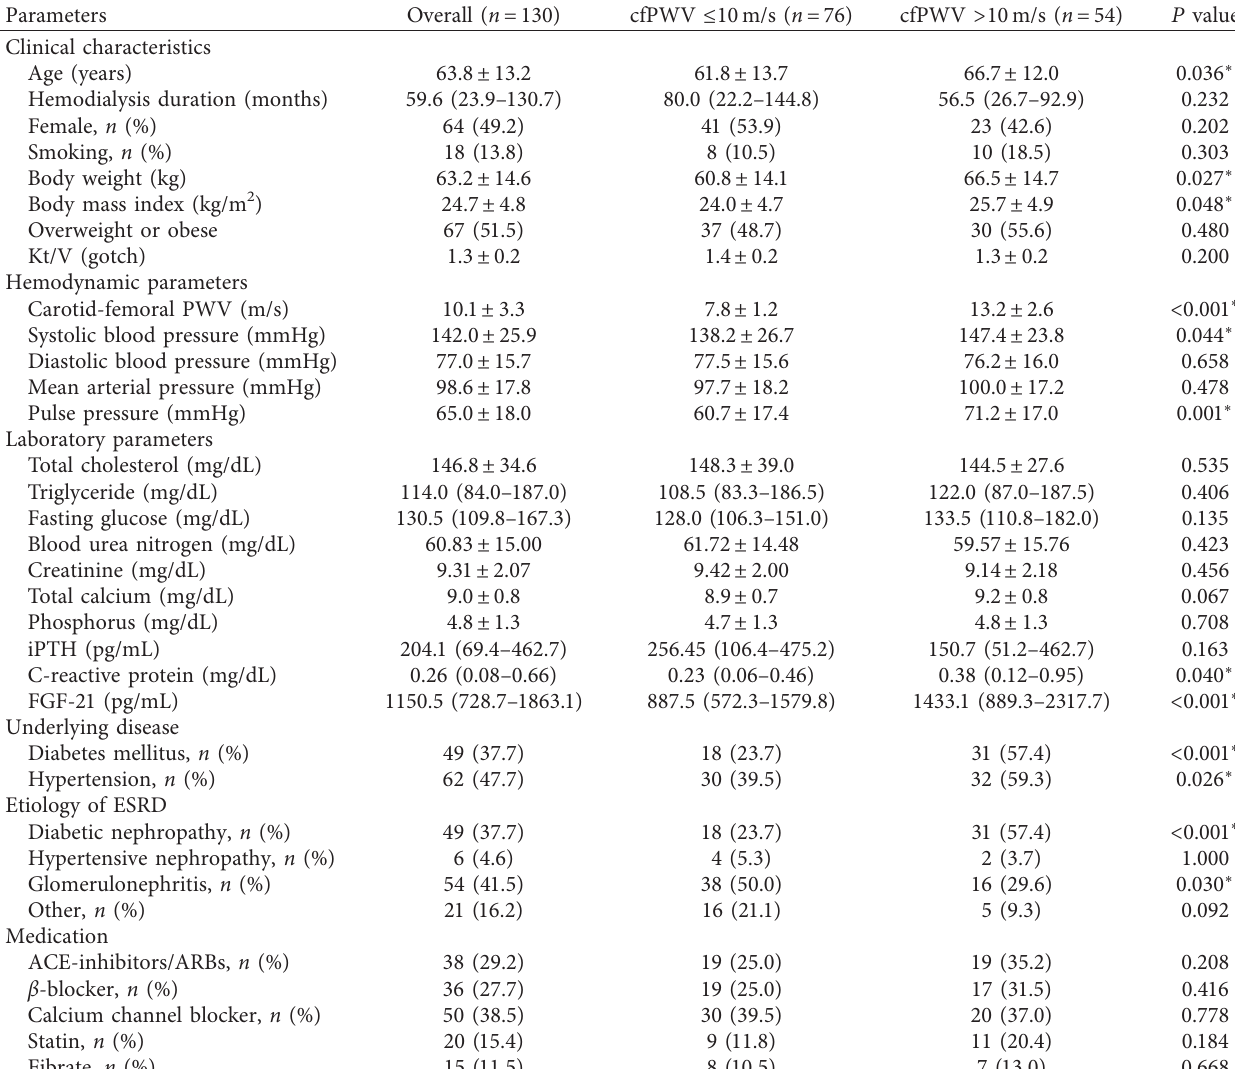
Table 1: Clinical characteristics of the study